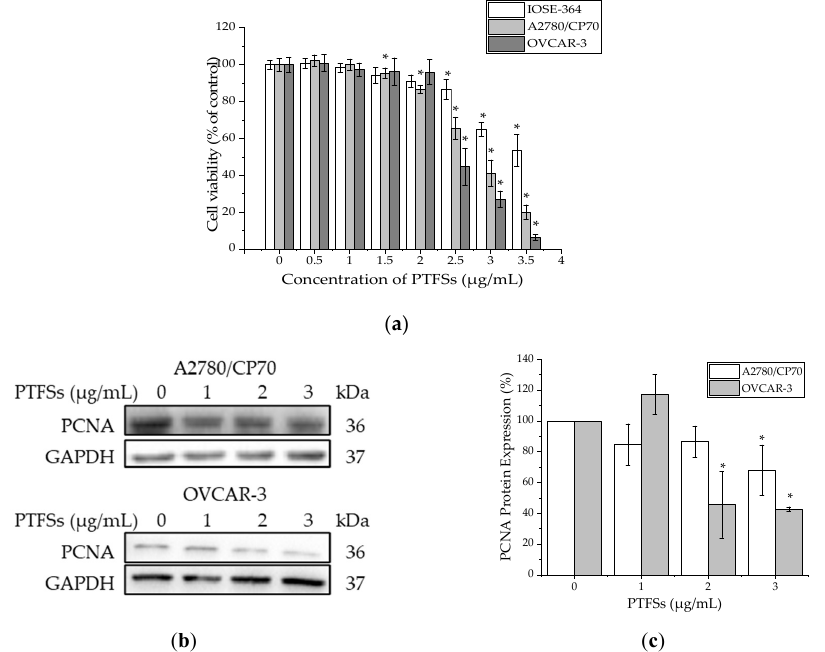
Figure 2. Cytotoxicity and proliferation inhibition effects of PTFSs on A2780/CP70, OVCAR-3 and IOSE-364 cells. ( a ) Cell viability, 24 h after treatment with different concentrations of PTFSs (0–3.5 μg/mL), was examined using the MTS assay. ( b, c ) Effects of PTFSs (0, 1, 2, 3 μg/mL) on the expression of proliferating cell nuclear antigen (PCNA) were determined by Western blotting. GAPDH was utilized for an endogenous reference to standardize protein levels. All values were expressed as mean ± standard error of mean (SEM) of three independent experiments. * p < 0.05 versus control.